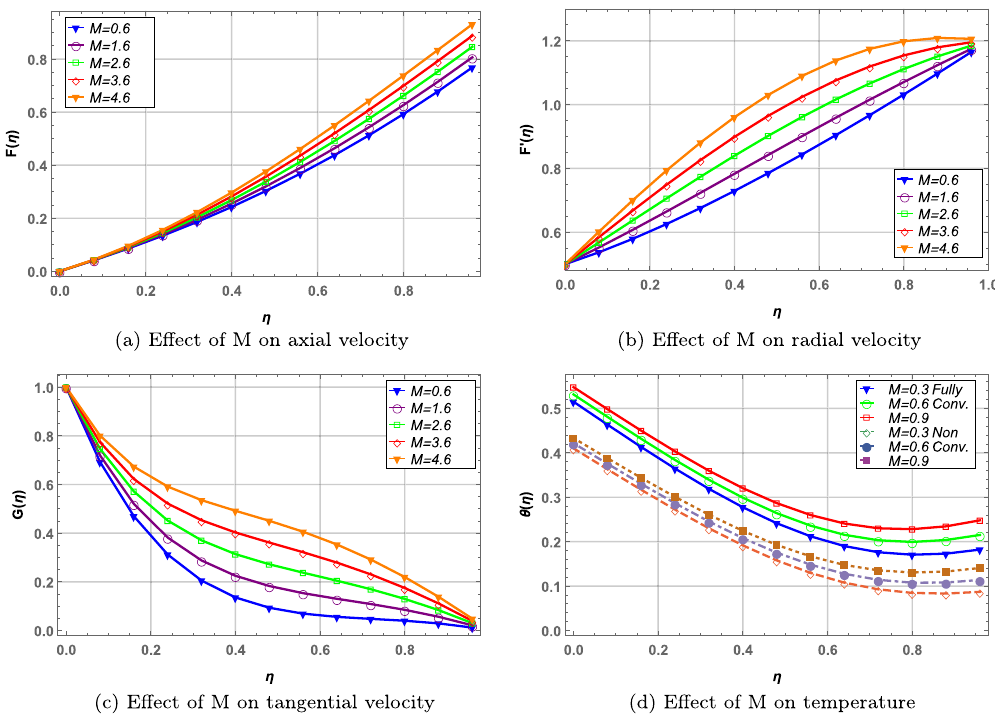
Figure 3. Effect of magnetic interaction parameter on velocity and temperature